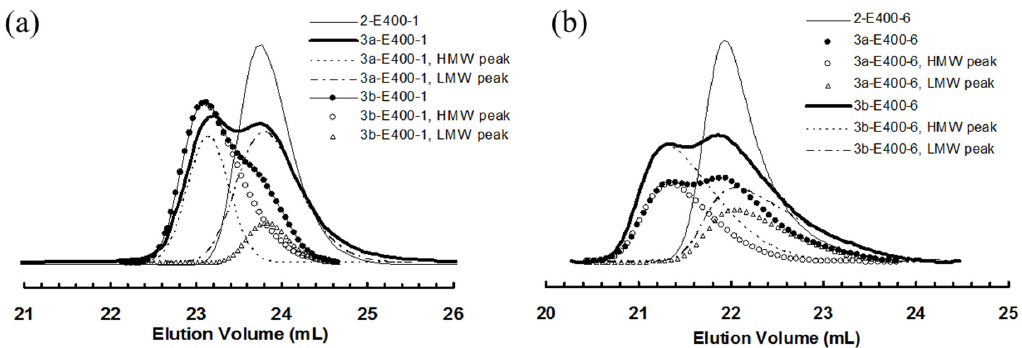
Figure 6. ( a ) Comparison of GPC elution curves for 2-E400-1, 3a-E400-1 and 3b-E400-1; and ( b ) comparison of GPC elution curves for 2-E400-6, 3a-E400-6 and 3b-E400-6.